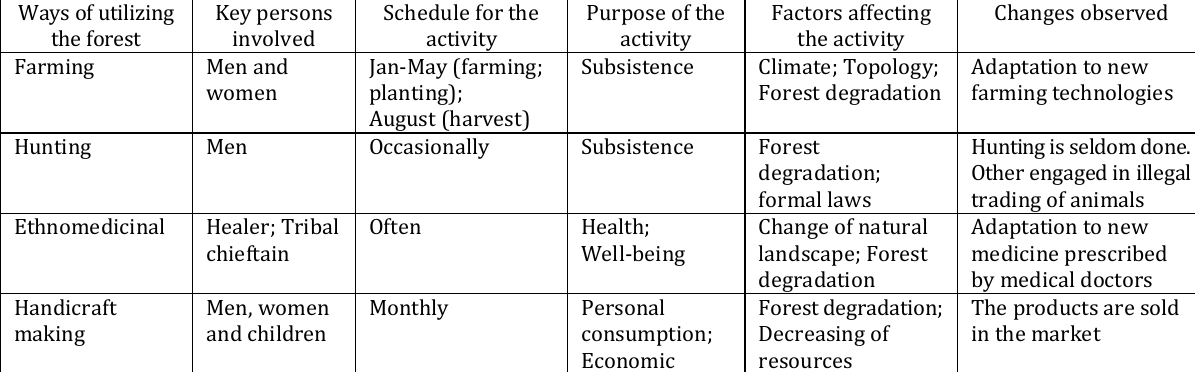
Table 1. Summary of the activities used for forest utilization